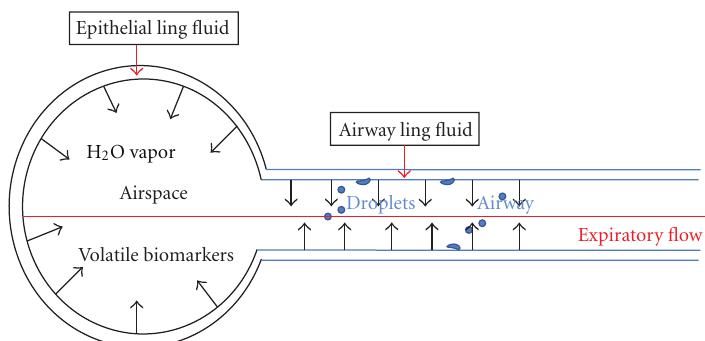
Figure 1: Nonvolatile and volatile components in EBC. Water vapor is rapidly di ff used from the lining fluid on the surface of the airway (bronchi) and airspace (alveolar) into the expiratory flow. Droplets (nonvolatile biomarker) formation in the lung is largely from the lining fluid of the airway where turbulence is encountered. Respiratory gases (volatile biomarkers) are from both airspace and airway, and more soluble vapors are typically greater in the airway [5, 67].